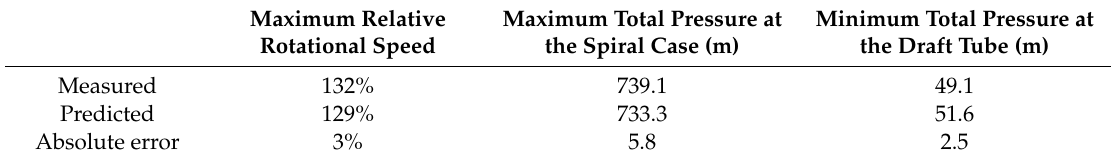
Table 3. Comparison between measured and predicted results in single load rejection.